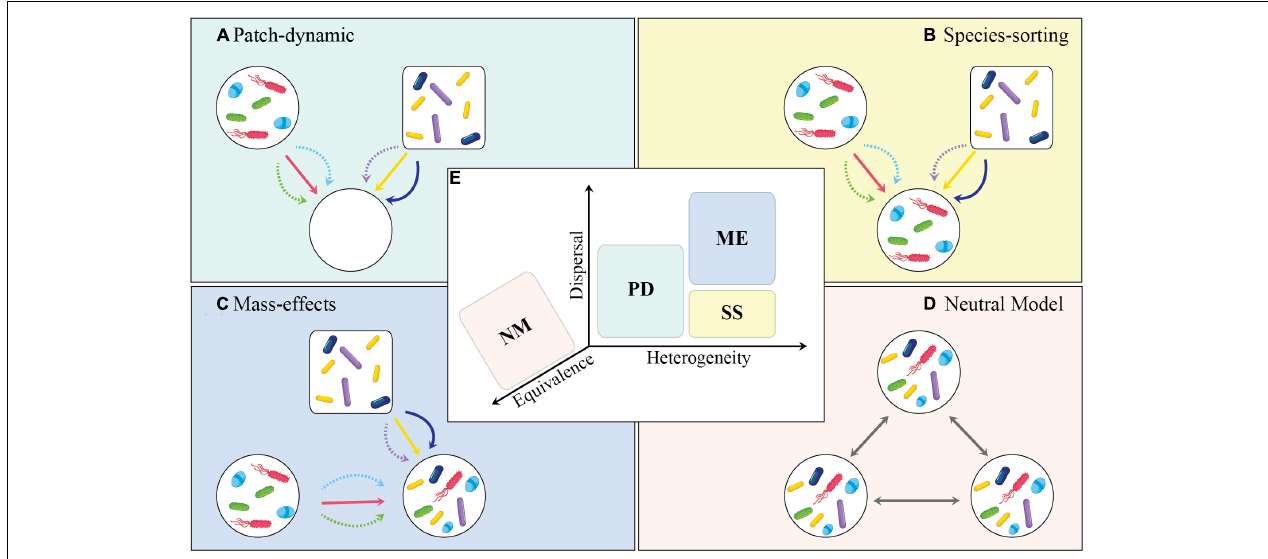
FIGURE 3 | Conceptual diagram depicting the importance of dispersal in metacommunity theory. Each panel shows one of the metacommunity paradigms: (A) Patch-dynamic (PD), (B) species-sorting (SS), (C) mass-effects (ME), and (D) neutral model (NM). (E) Metacommunity paradigms in relation to their place along the axes of dispersal, environmental heterogeneity, and equivalence. In (A–D) , the shapes of communities (i.e., circle and rectangle) indicate differences in abiotic conditions. Different microbial taxa are shown to disperse at different rates, i.e., solid lines indicate higher dispersal rates and dashed lines indicate lower dispersal rates. (A) Open patches offer new colonization opportunities as well as evolutionary tradeoffs in colonization and competition. (B) Local selection counterbalances the effect of dispersal in determining the community structure. (C) High levels of dispersal override the potential effect of local selection. (D) Neutral model assumes that all taxa are equally adept at dispersing and the environmental conditions are equivalent across patches. (A–D) Are adopted and modified from Leibold et al. (2004), and (E) was adopted from Logue et al. (2011).